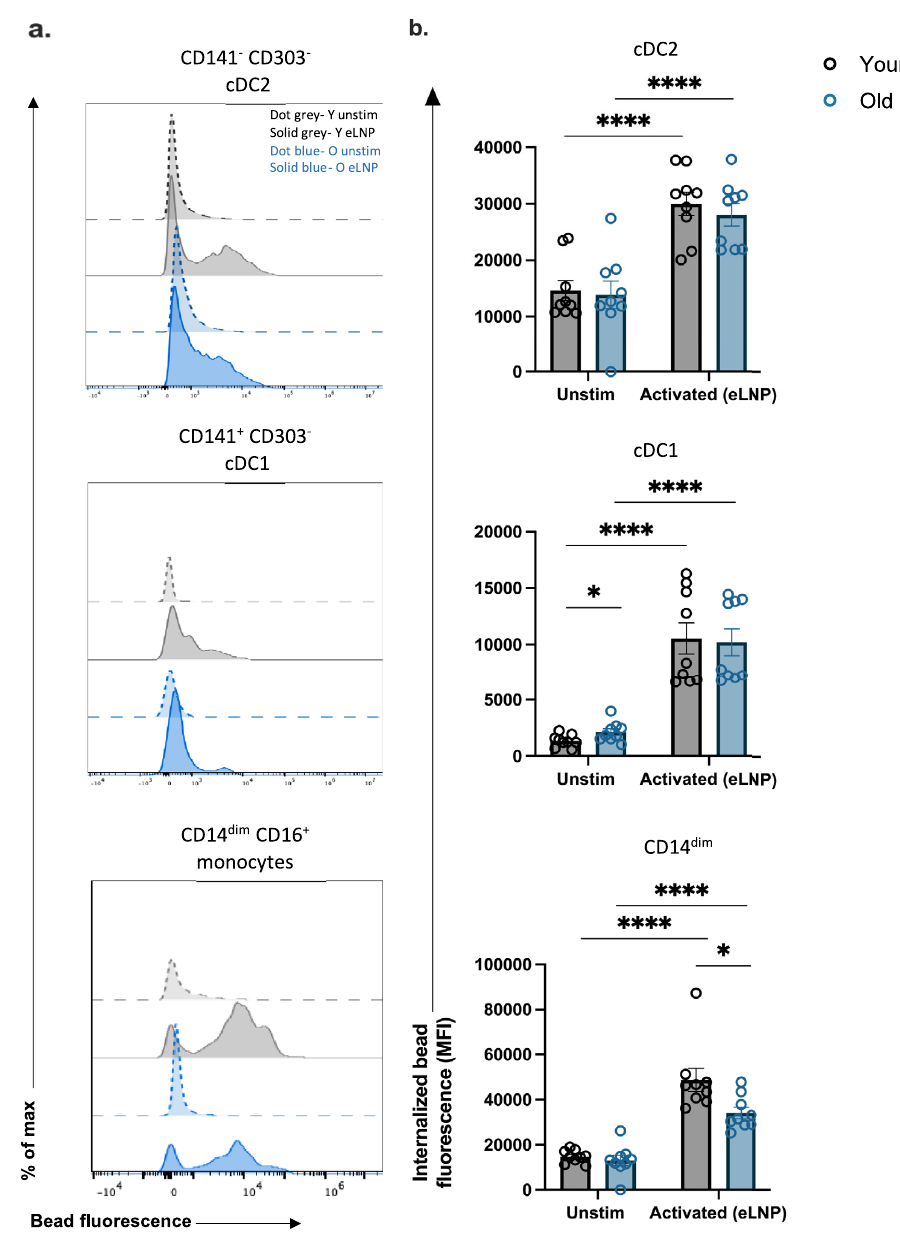
Fig. 6 Phagocytosis is induced in response to eLNP stimulation. a , b Phagocytosis is induced in cDC2, cDC1, CD14 dim CD16 + monocytes. Phagocytosis measured using fl uorescent beads and multiparametric fl ow cytometry. PBMCs were incubated overnight with stimulus and with beads for a further 3 h. Dotted grey line represents an example of a young donor unstimulated. Solid grey represents an example of a young donor stimulated with eLNP. Dotted blue line represents an example of an older donor unstimulated. Solid blue represents an example of an older donor stimulated with eLNP. Each individual circle represents one individual subject. n = 9, * P < 0.05, ** P < 0.01, *** P < 0.001, and **** P < 0.0001 by non-parametric Mann Whitney